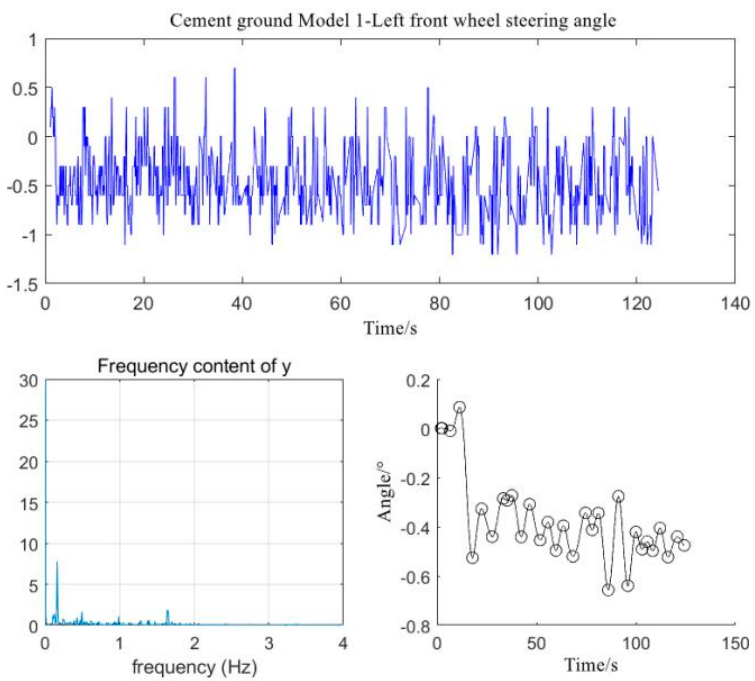
Figure 9. Analysis data for the right front wheel steering angle in mode 1.